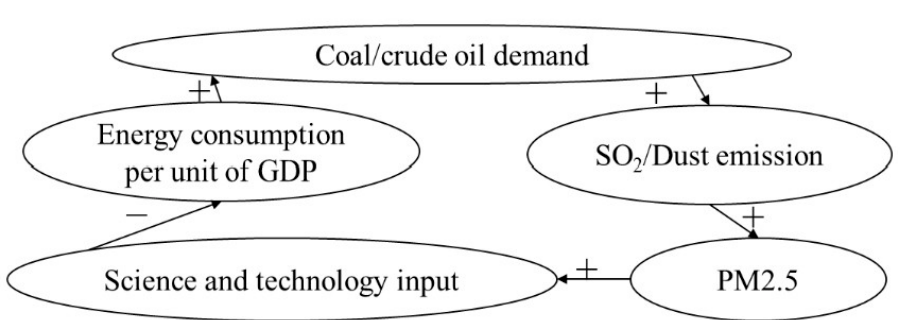
Figure 6. Causality diagram of Beijing energy consumption system per unit GDP. Green coverage is the ratio of vertical projection area of various types of green space to the total urban area, and is an important indicator to measure the urban environmental quality. The improvement in urban greening rate can give full play to the important role of plants in reducing urban haze pollution. The causality diagram between urban green coverage and urban haze in Beijing is shown in Figure 7.